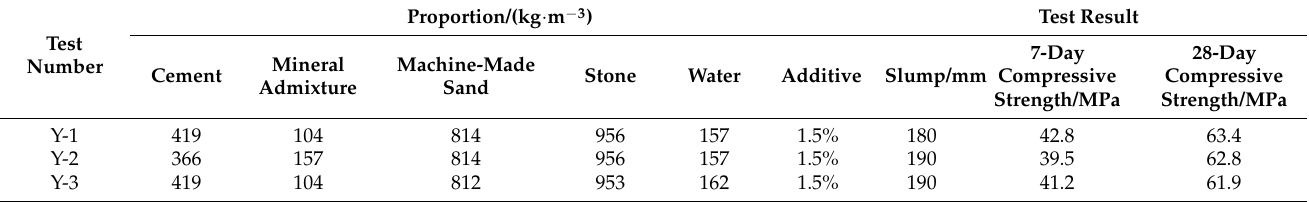
Table 9. Test verification ratio parameters and test